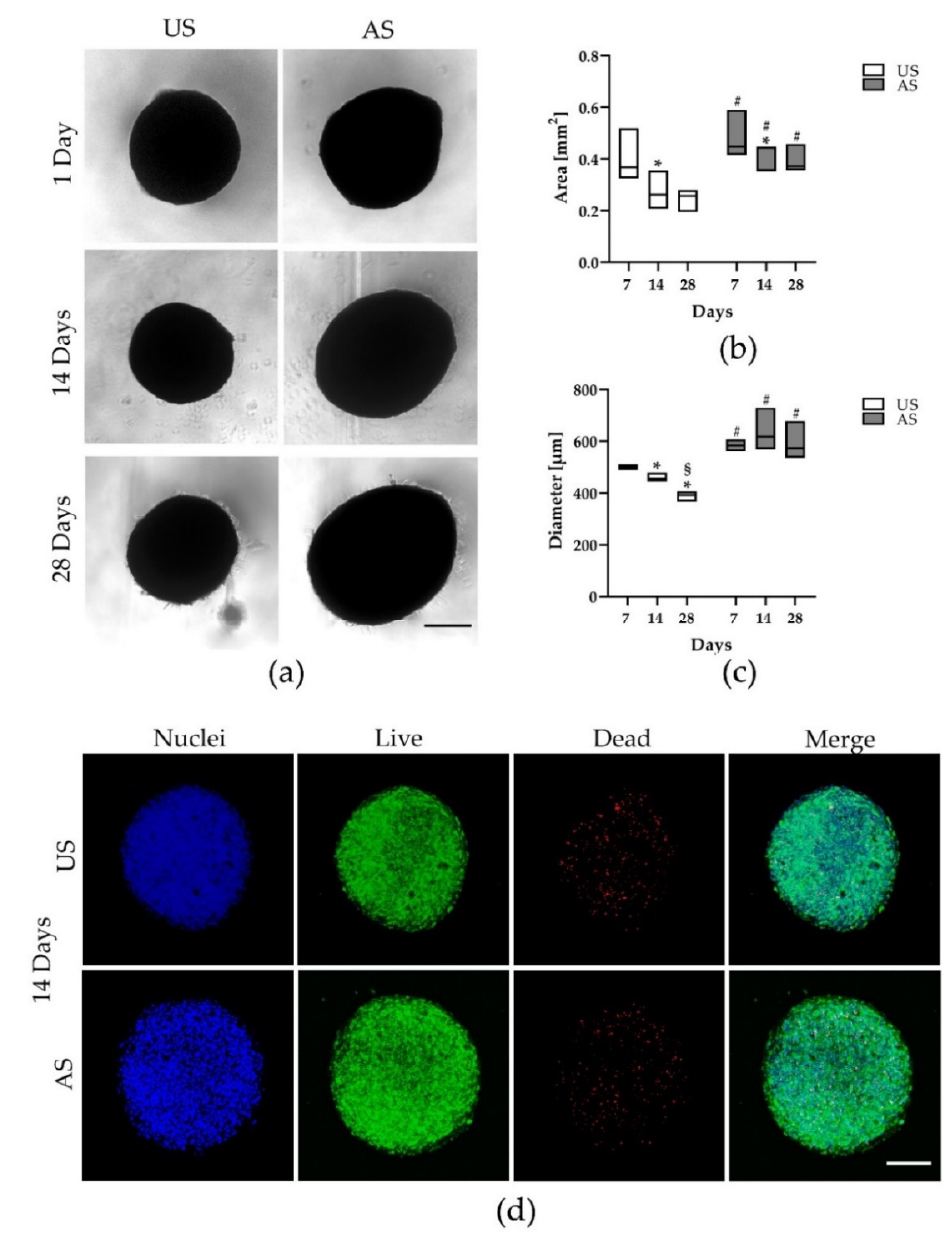
Figure 1. Analysis of spheroid morphology and size. ( a ) Imaging of unstimulated (US) and adipogenically stimulated (AS) spheroids after 1, 14, and 28 days ( n = 3, phase contrast, Axiovert 25, scale bar: 200 µm). ( b ) Analysis of the spheroid area and ( c ) the spheroid diameter of unstimulated and adipogenically stimulated spheroids after 7, 14, and 28 days (* significantly different from day 7 of the respective stimulation, * p < 0.05; # significantly different from the respective time point of unstimulated culture, # p < 0.05; § significantly different from day 14 of the respective stimulation, § p < 0.05; One-way ANOVA post hoc uncorrected Fisher´s LSD with n = 3 for area measurement by image analysis using ImageJ and n = 4 for diameter measurement by image analysis using Zeiss Zen lite). ( d ) Live/dead staining of an unstimulated and an adipogenically stimulated spheroid after 14 days ( n = 4, LSM 780, Zen black software, overlay of Z-stack, green: live, red: dead, blue: nuclei; scale bar: 200 µm).